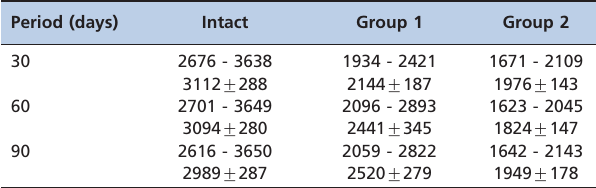
Table 2 - Axial ultrasound velocity (m/s) for the intact and operated tibiae according to group and period (range, average and SD).